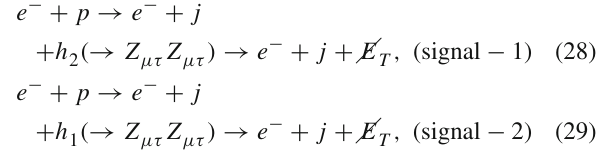
and LHeC with E e − = 60 GeV (dotted). From Fig. 5, we can see that, for 1 × 10 − 5 GeV ≤ χ ≤ 2 × 10 − 4 GeV, the values of the Z μτ production cross sections are in the ranges 3 . 61 × 10 − 5 pb ≤ σ ≤ 1 . 75 × 10 − 2 pb (solid), 1 . 94 × 10 − 5 pb ≤ σ ≤ 9 . 37 × 10 − 3 pb (dashed) and 8 . 16 × 10 − 6 pb ≤ σ ≤ 3 . 97 × 10 − 3 pb